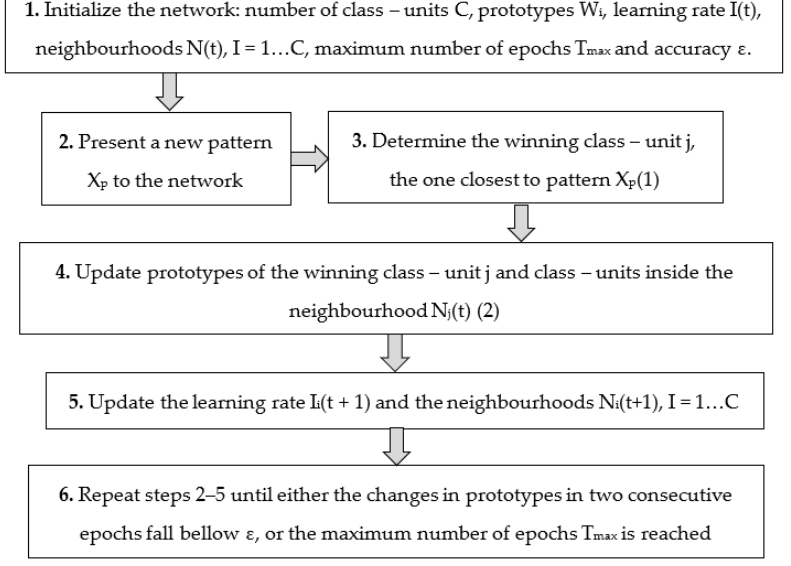
Figure 1. SOM training algorithm steps.